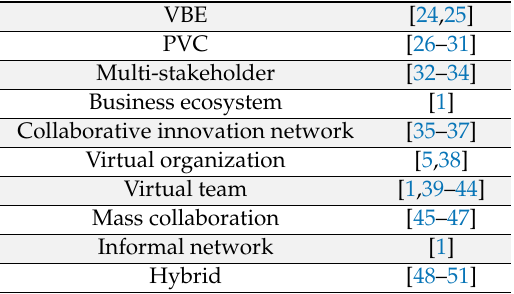
Figure 2. Types and percentages of mentioned structures in the collected papers. Table 5. Examples of addressed structures and corresponding